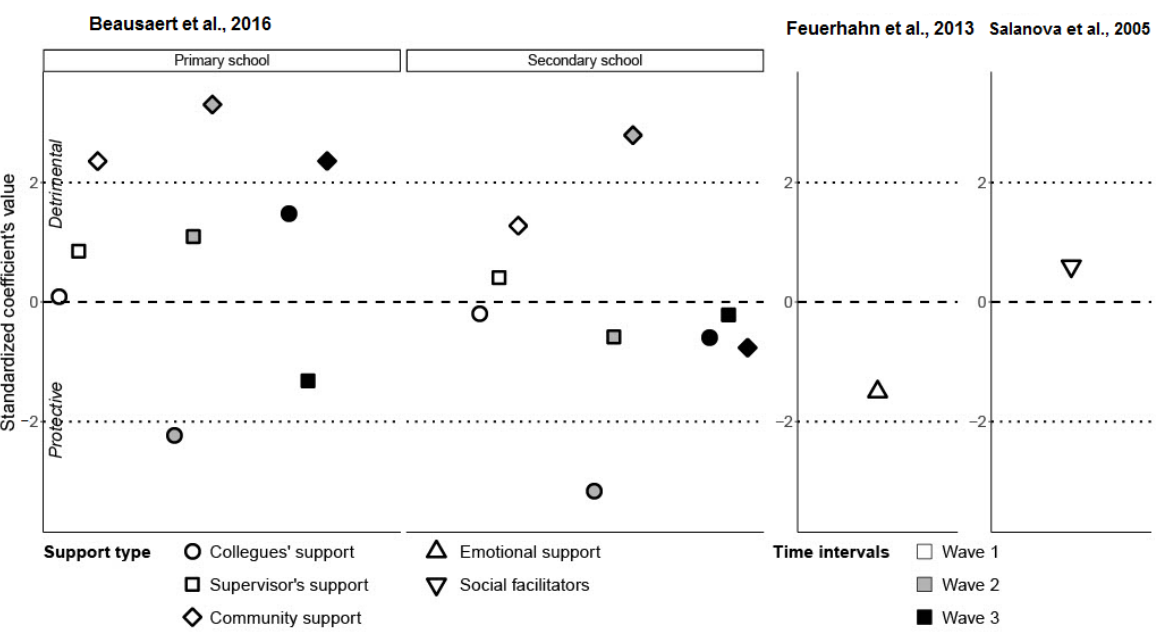
Figure 2. Three studies representing support category of determinants (Beausaert et al., 2016; Feuerhahn et al., 2013; Salanova et al. 2005) [47–49].